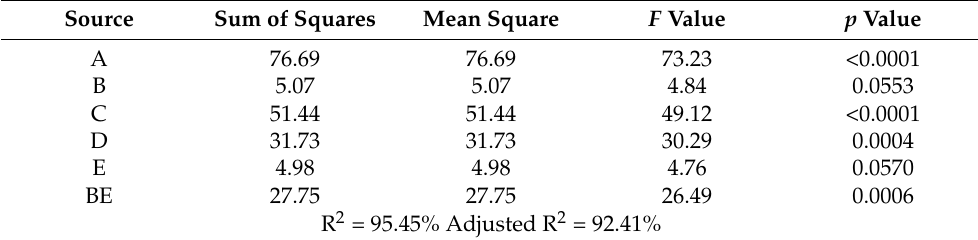
Table 4. ANOVA analysis of DTS.